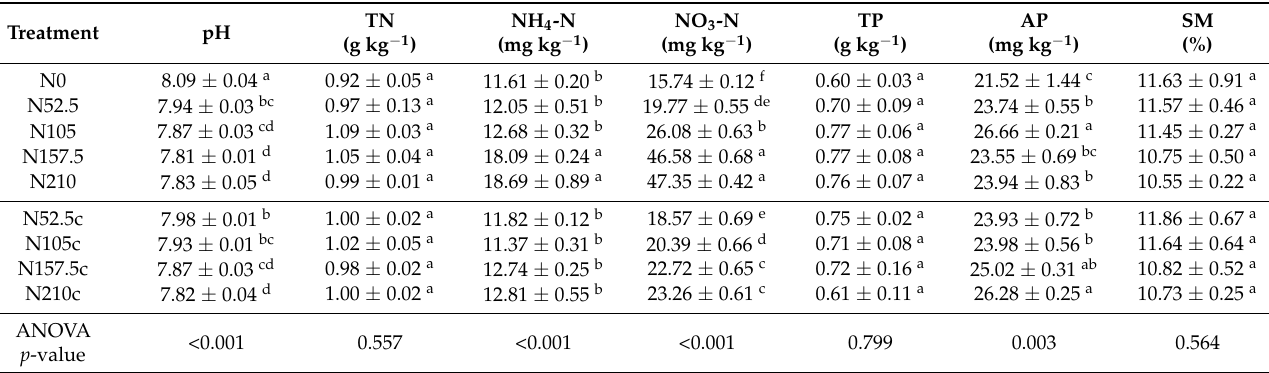
Figure 5. The importance of species (variables) points of the top 30 soil bacterial genera as affected by N fertilization. The abscissa is a measure of importance, and the ordinate is the name of the species sorted by importance. Table 3. Soil physiochemical parameters as affected by N